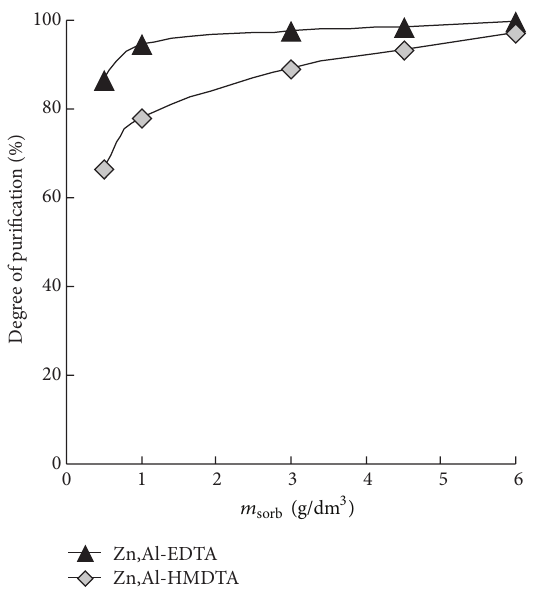
Figure 6: Effect of carbonate ion concentration on U(VI) sorption with different forms of adsorbents: (1) Zn,Al-CO 3 and (2) Zn,Al-